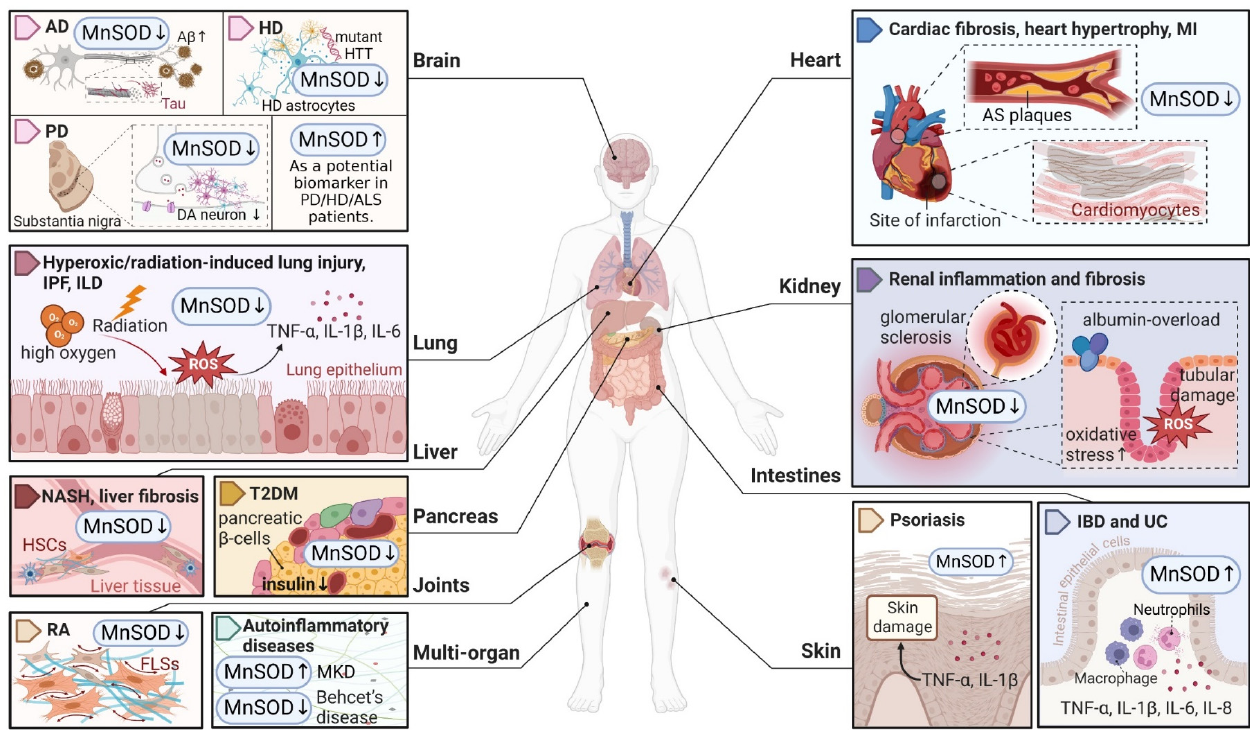
Figure 1. An overview of MnSOD expression in various pathological states of human diseases. Abnormal expression levels of MnSOD have been detected in multiple diseases and have a wide impact on different organs, followed by various pathological alterations such as inflammation, fibrosis, sclerosis, and neuron degeneration. MnSOD, manganese superoxide dismutase; ROS, reactive oxygen species; AD, Alzheimer’s disease; A β , amyloid β -protein; HD, Huntington’s disease; HTT, huntingtin; PD, Parkinson’s disease; DA, dopaminergic; ALS, amyotrophic lateral sclerosis; IPF, idiopathic pulmonary fibrosis; ILD, interstitial lung disease; TNF, tumour necrosis factor; IL, interleukin; NASH, non-alcoholic steatohepatitis; HSCs, hepatic stellate cells; T2DM, type 2 diabetes mellitus; RA, rheumatoid arthritis; FLSs, fibroblast-like synoviocytes; MKD, mevalonate kinase deficiency; MI, myocardial infarction; AS, atherosclerosis; IBD, inflammatory bowel disease; UC, ulcerative colitis. ‘ ↑ ’ represents increased or upregulated, while ‘ ↓ ’ represents decreased or downregulated (created with BioRender.com (accessed on 4 November 2022)).